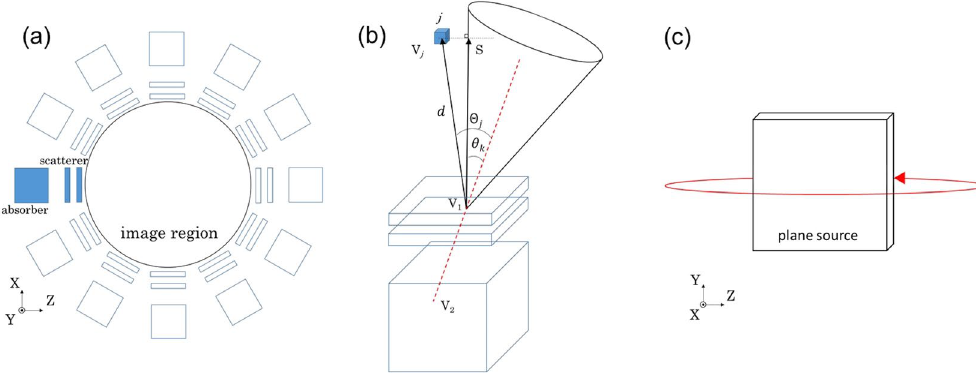
Figure 6. ( a ) Configuration of the multi-angle data acquisition measurement, ( b ) diagram of the 3-D MLEM reconstruction, and ( c ) configuration of the measurement of the plane